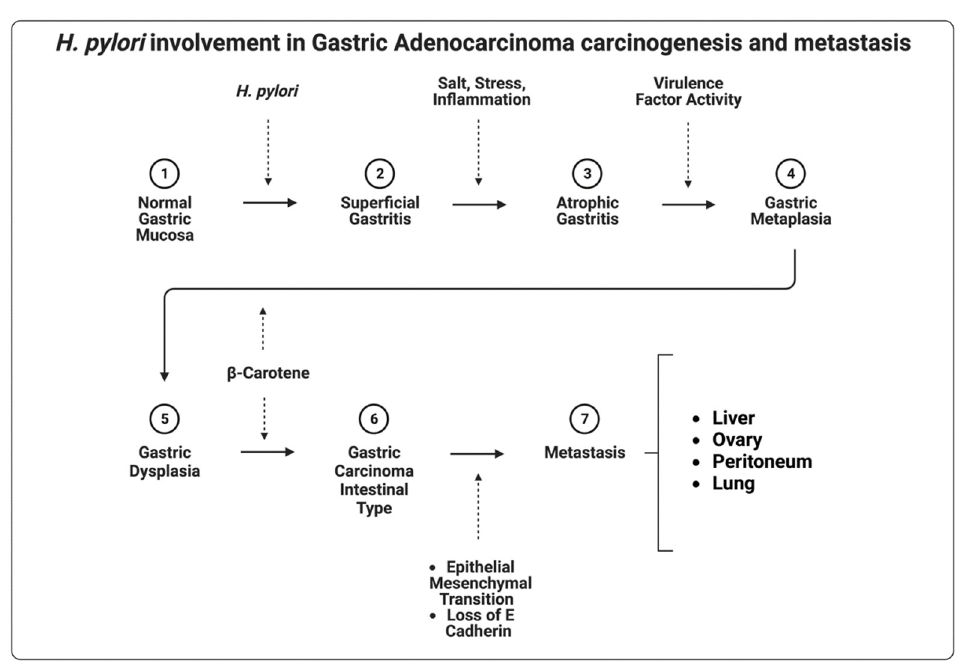
Figure 2. Gastric adenocarcinoma begins as superficial gastritis and can progress into atrophic gastritis, metaplasia, dysplasia, and gastric adenocarcinoma, followed by metastatic disease as the feared outcome. Superficial gastritis due to H. pylori is more likely to lead to intestinal type gastric adenocarcinoma.